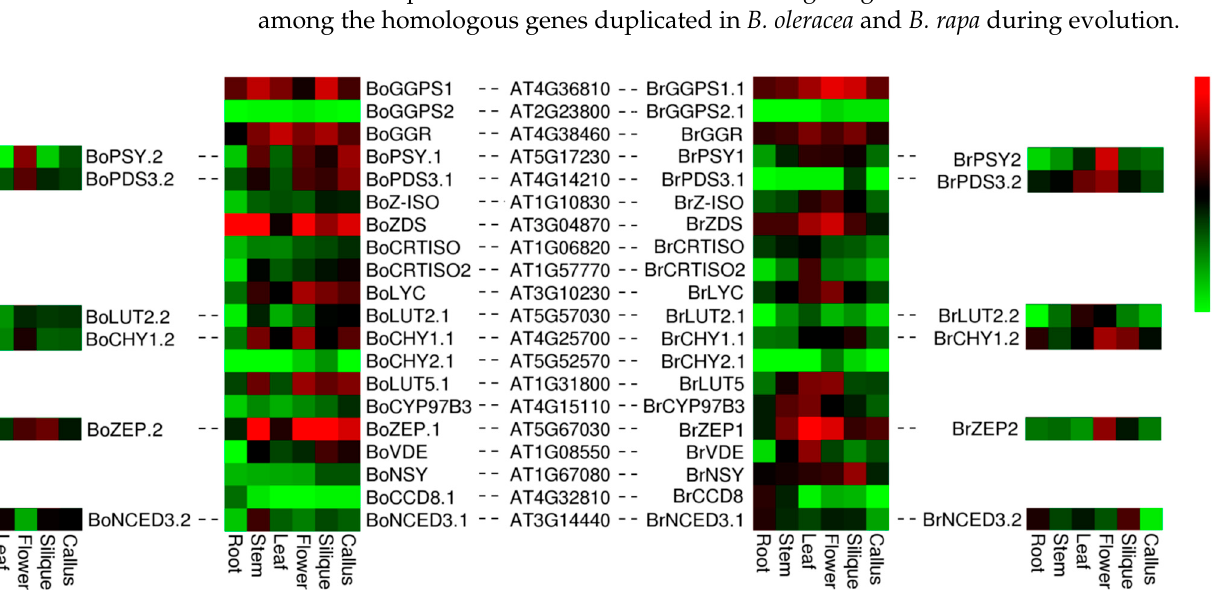
Figure 5. Relative expression levels of nine key carotenoid biosynthetic genes in different tissues of cabbage.